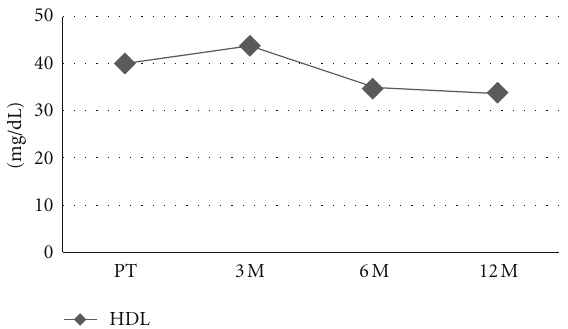
Figure 3: HDL changes during ADT. HDL: high-density lipopro- tein, PT: pretreatment, 3M: 3 months; 6M: 6 months; 12M: 12